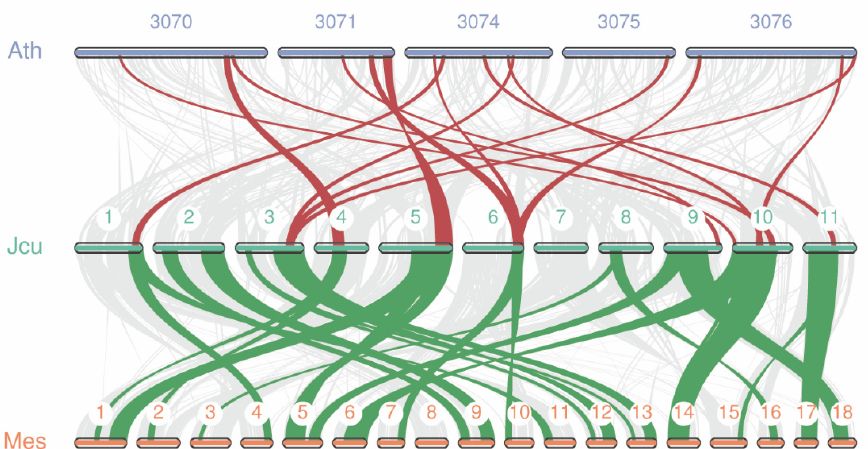
Figure 6. LBD genes synteny analysis among the three species J. curcas , cassava, and A. thalina . The grey lines on the background indicate the collinear blocks within J. curcas and other species genomes, and the hilighted lines are the collinear blocks containg the LBD genes. Ath, Jcu, and Mes represents A. thalina , J. curcas , and cassava, respectively. 3070, 3071, 3074, 3075, and 3076 respresnt chromsomes NC_003070.9, NC_003071.7, NC_003074.8, NC_003075.7, and NC_003076.8, respectively. 1–11 in green represent chromosomes chr1–chr11, respectively. 1–18 in orange represent chromosomes Chromosome01–Chromosome18, respectively.